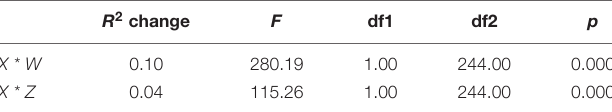
TABLE 2 | Descriptive statistics and intercorrelations among variables ( N = 250).